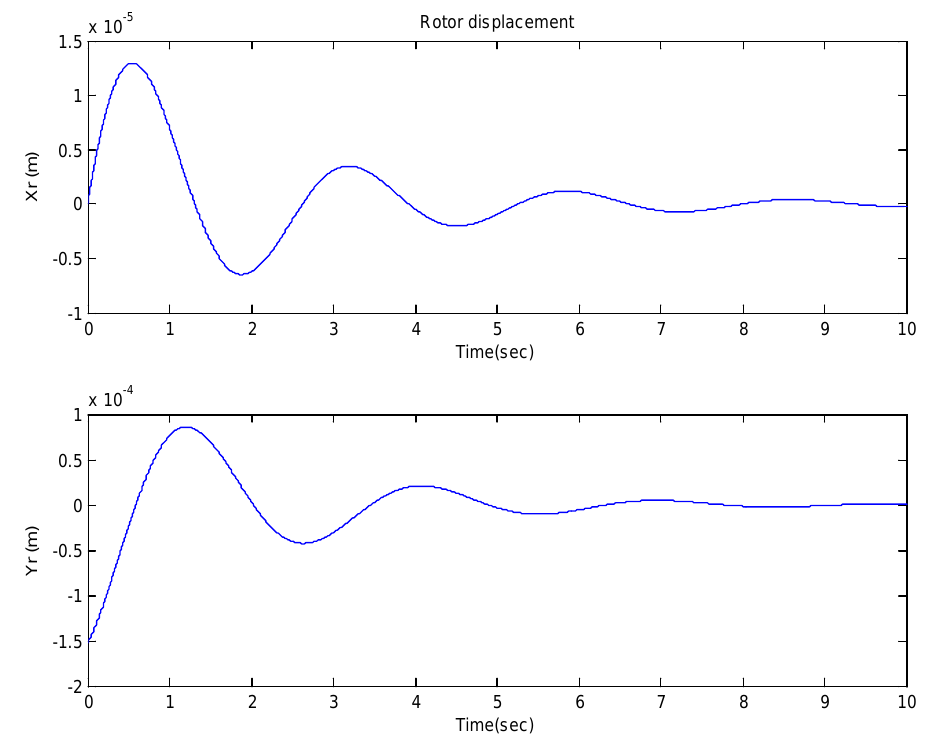
Figure 5. Simulation result: rotor displacement responses. For the experimental validation, the rotor displacements are measured by the laser displacement sensor of Keyence, LK-G35 with a resolution of 0.05 µ m. The power amplifier is made by Advanced Motion Control with Model 25A20. The controller is implemented using dSPACE’s DS 1103 motion-control card. The same control parameters as the simu- lation ones have been taken. To de-noise the measured signal, a Butterworth filter with bandwidth 600 Hz is taken: